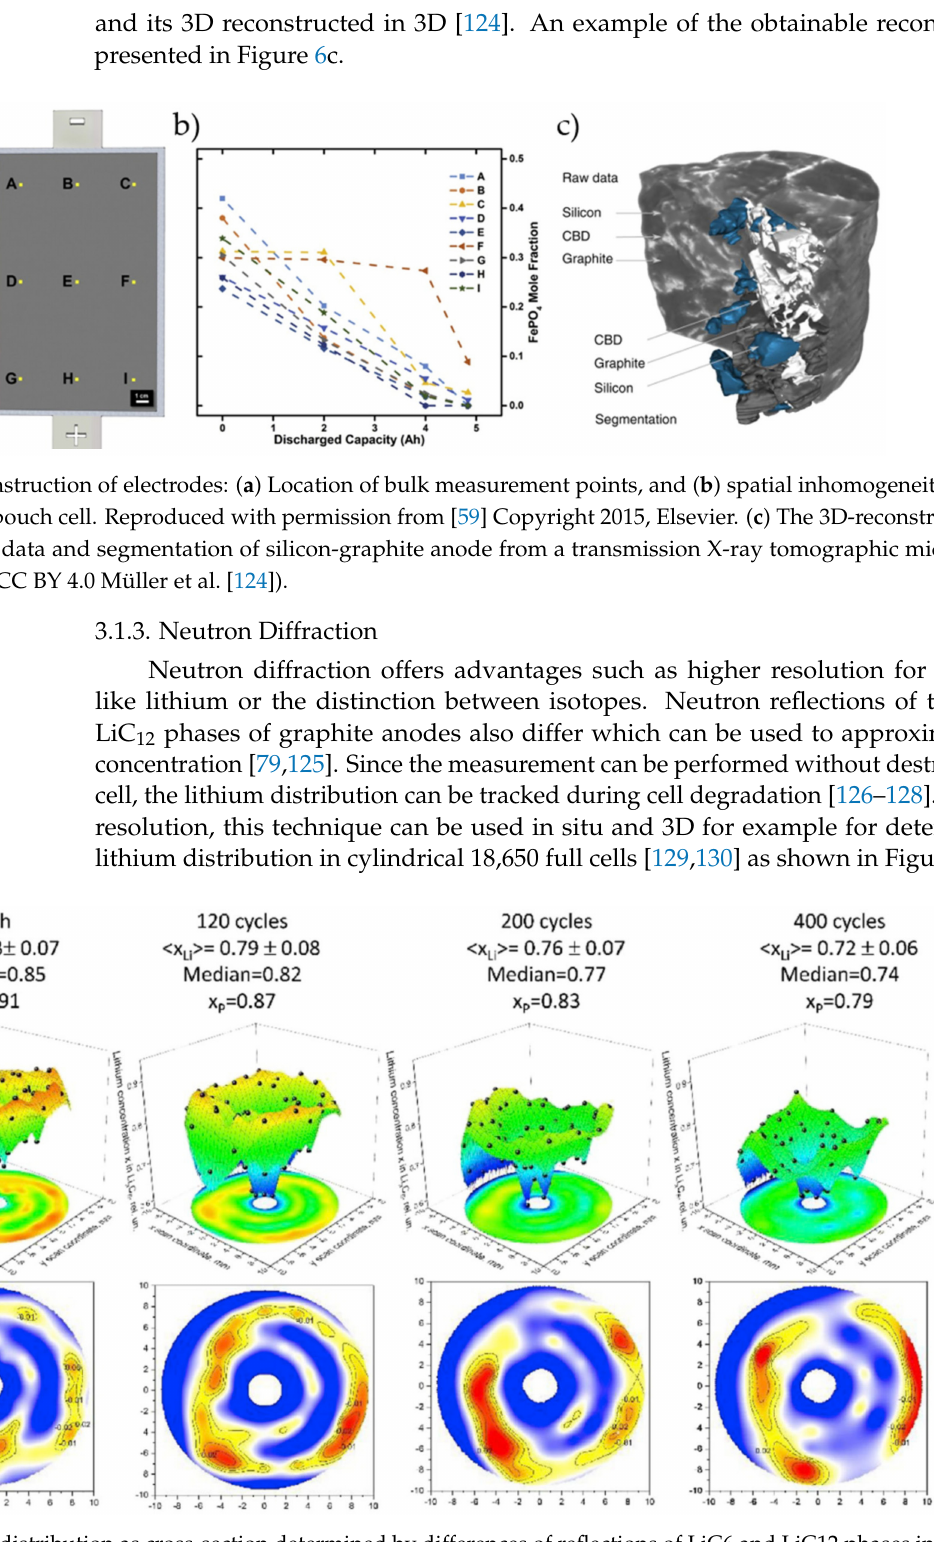
Figure 7. Lithium distribution as cross-section determined by differences of reflections of LiC6 and LiC12 phases in graphite with spatially resolved neutron diffraction. Over cycling inhomogeneities enhance. Reproduced with permission from [130] Copyright 2020,